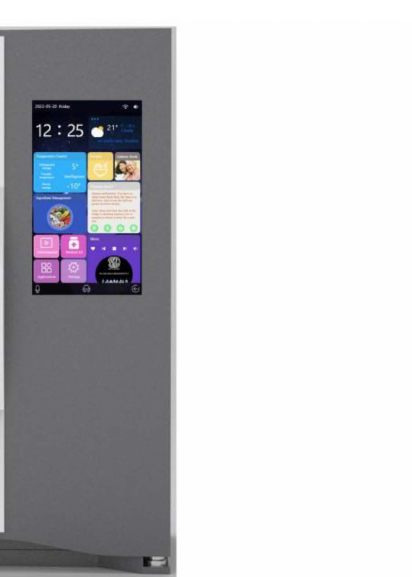
Figure 4. Scheme (A): Product and interaction interface.